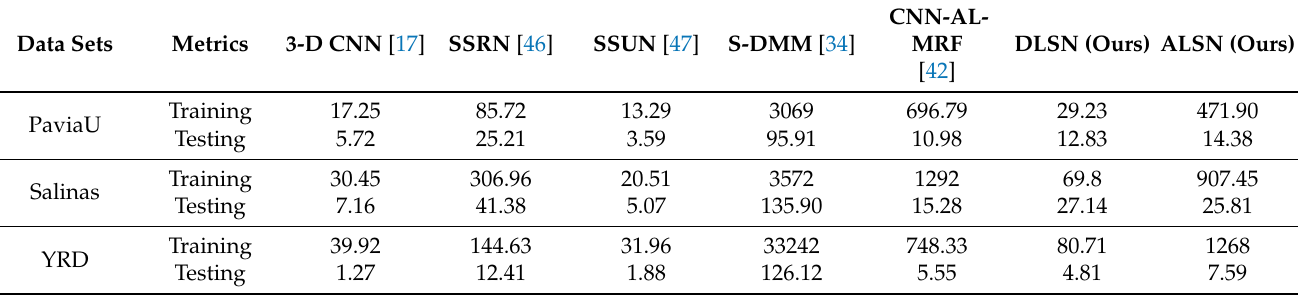
Table 8. Time cost (s) of different